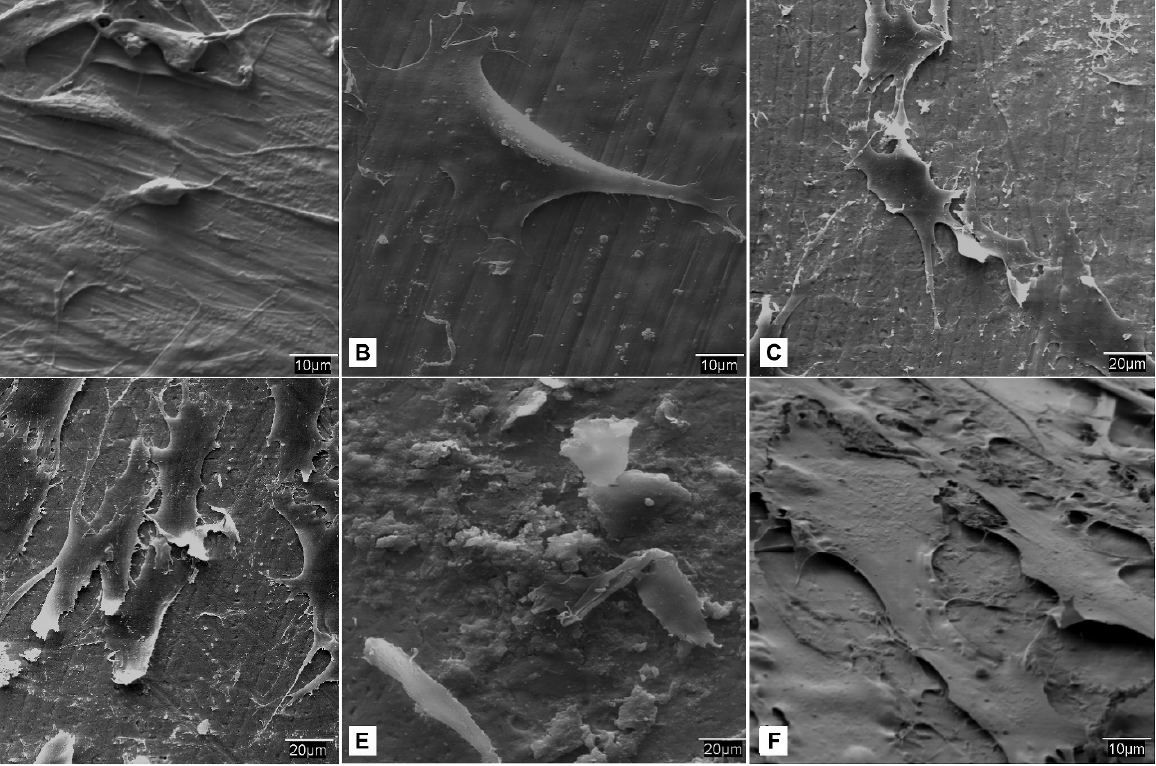
Figure 9. SEM Study of the sowing of MSCat in different incubation periods: ( A ) shows seeding on control screw observed at 1000× after 24 h; ( B ) shows seeding on control screw observed at 1000× after 7 days; ( C , D ) shows seeding on control screw observed at 500× after 14 days; ( E ) shows seeding on control screw observed at 500× after 21 days; ( F ) at 1000× from the surface of a screw belonging to the control group after 28 days of incubation where the formation of a multilayer with a slight dislocation of the most superficial cellular layer is observed.